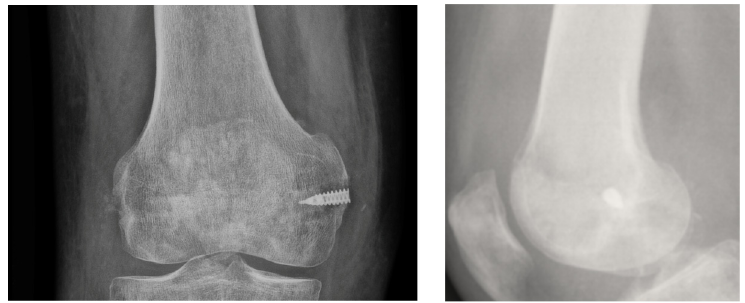
Figure 2. TWINFIX on the epicondyle footprint for medial collateral ligament, at the time of Anterior Cruciate Ligament ACL reconstruction.